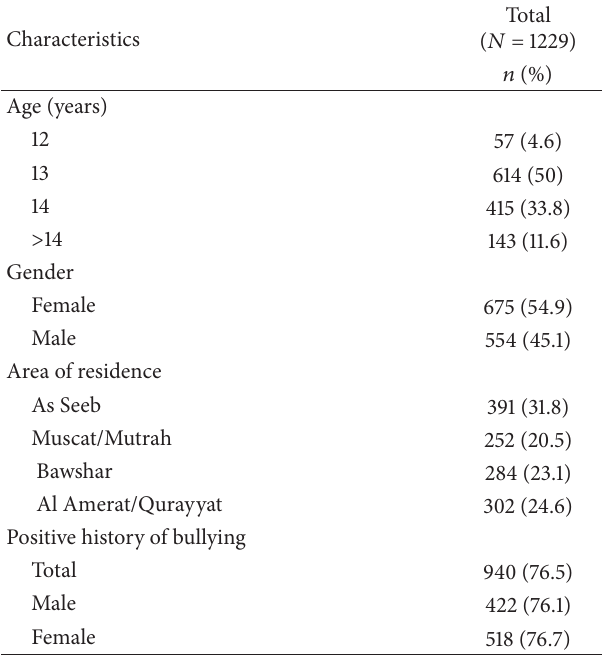
Table 1: Sociodemographic characteristics of the study participants, Oman,